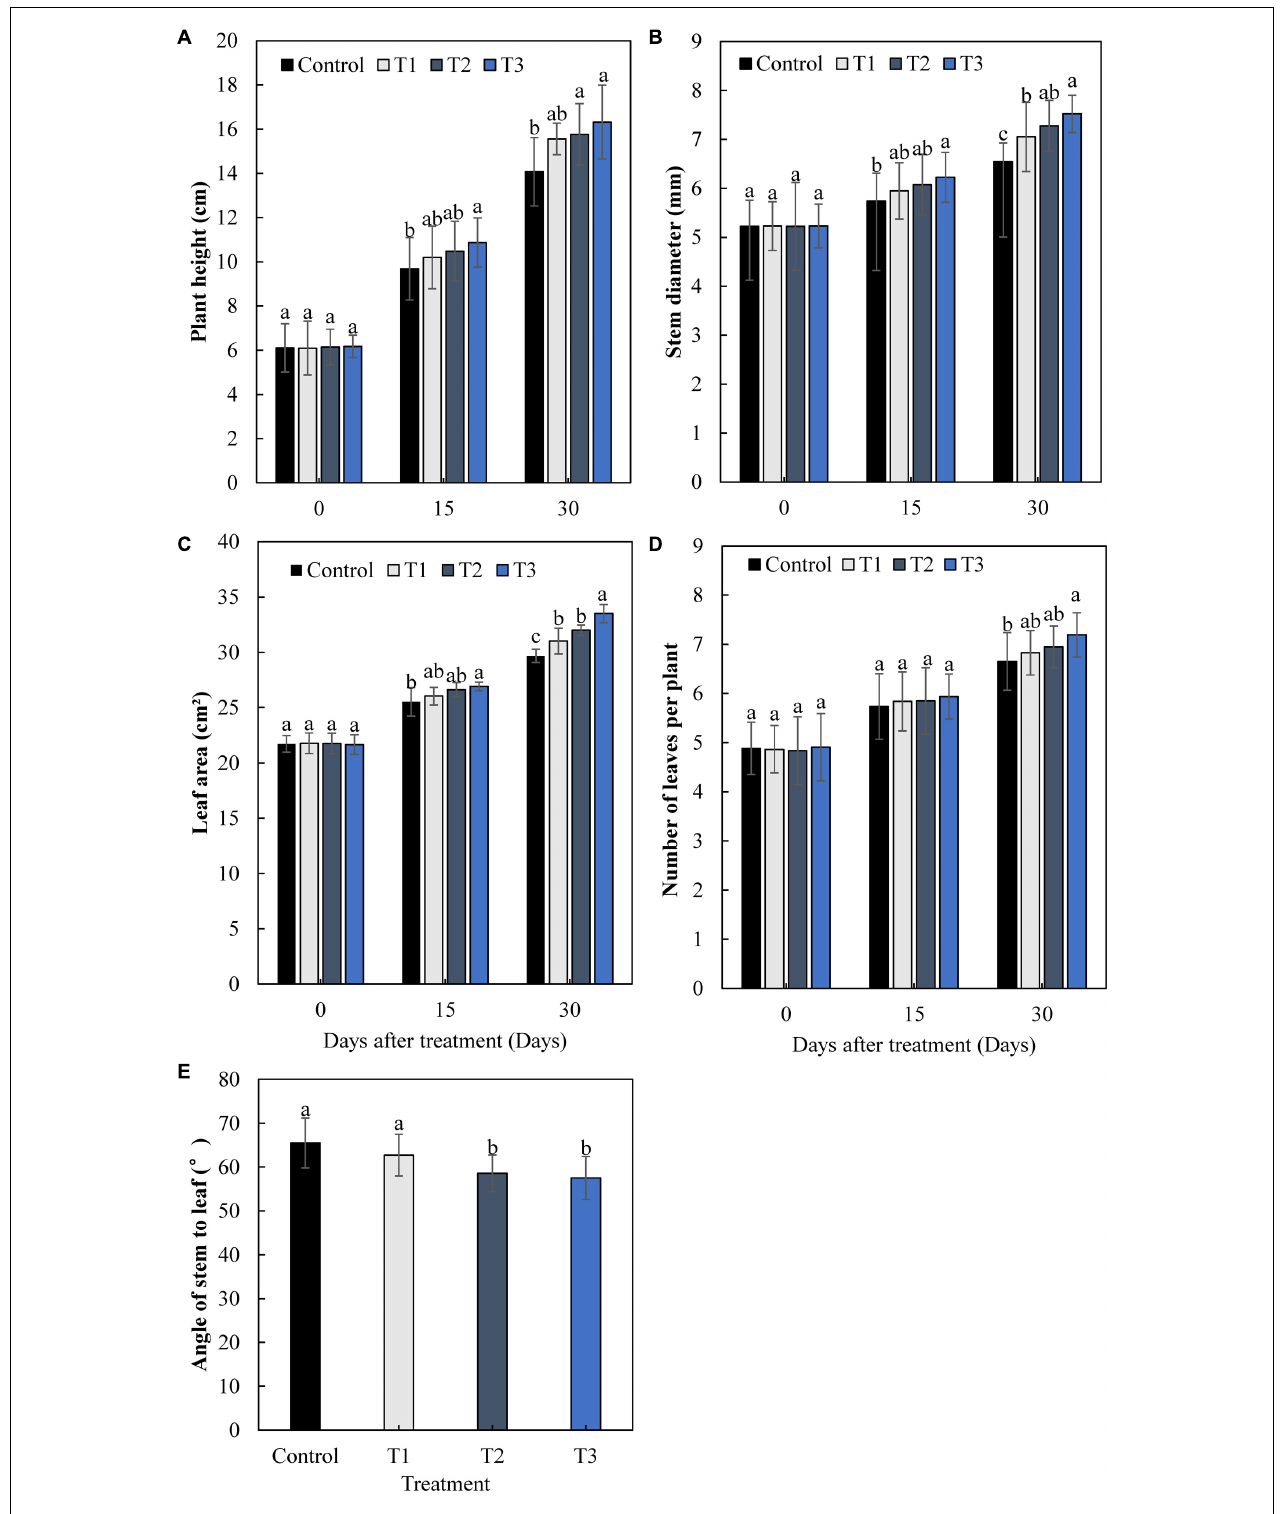
FIGURE 2 | Effects of supplemental LED light duration on cucumber plant height (A) , stem diameter (B) , leaf area (C) , number of leaves (D) , and angle between stem and leaf (E) . Cucumber plant height, stem diameter, leaf area, and number of leaves were measured at 0, 15, and 30 days after supplemental LED light treatments. Values are expressed as the mean ± SE ( n = 3). Bars that are significantly different based on the Duncan’s multiple range test ( p < 0.05) are indicated with different lowercase letters.